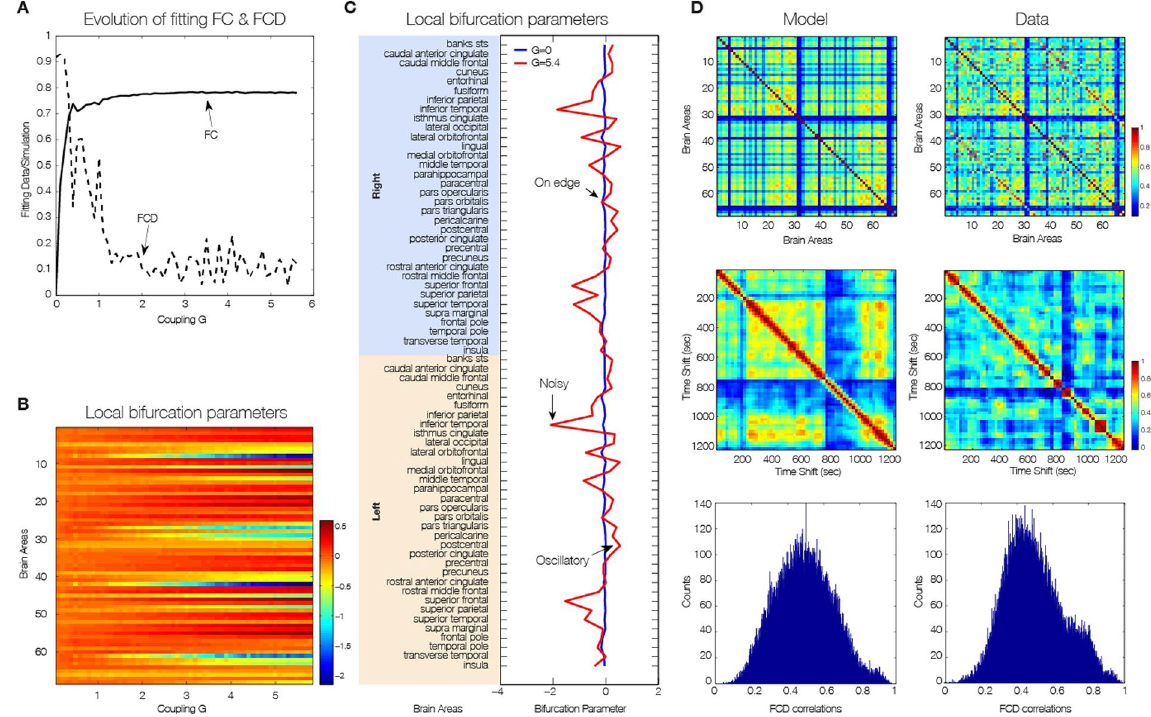
Figure 5. Spectral characteristics of the dynamical core of the human brain. To generate a heterogeneous brain network model (i.e. with different dynamics at each node), we optimized each single bifurcation parameter independently by fitting for each value of global coupling G the spectral characteristics of the simulated and empirical BOLD signals at each brain area. ( A ) The evolution of the fitting of the FC and FCD statistics as a function of G. For large enough value of the global coupling a good fitting of both is obtained, i.e. large correlation between the empirical and simulated grand average FC and low difference in the statistics of the empirical and simulated FCD (Kolmogorov-Smirnov distance). ( B ) The evolution of the single values of the local bifurcations parameters as a function of the global coupling G. For low values of G homogeneous local bifurcation parameters around zero are obtained. When the level of fitting improves for larger values of G a more heterogeneous distribution of is obtained. ( C ) The local bifurcation parameters for each region for the uncoupled network (i.e. G = 0) and for the optimal coupling (G = 5.4). If the network is uncoupled, each single brain area fitted the spectral characteristics of the empirical BOLD signals in a very homogeneous way by local bifurcations parameters at the edge of the local Hopf bifurcation, i.e. at zero. ( D ) When the whole-brain network is coupled, we can discover the “true” intrinsic local dynamics that fits the local empirical BOLD characteristics and the global quantities FC, FCD and